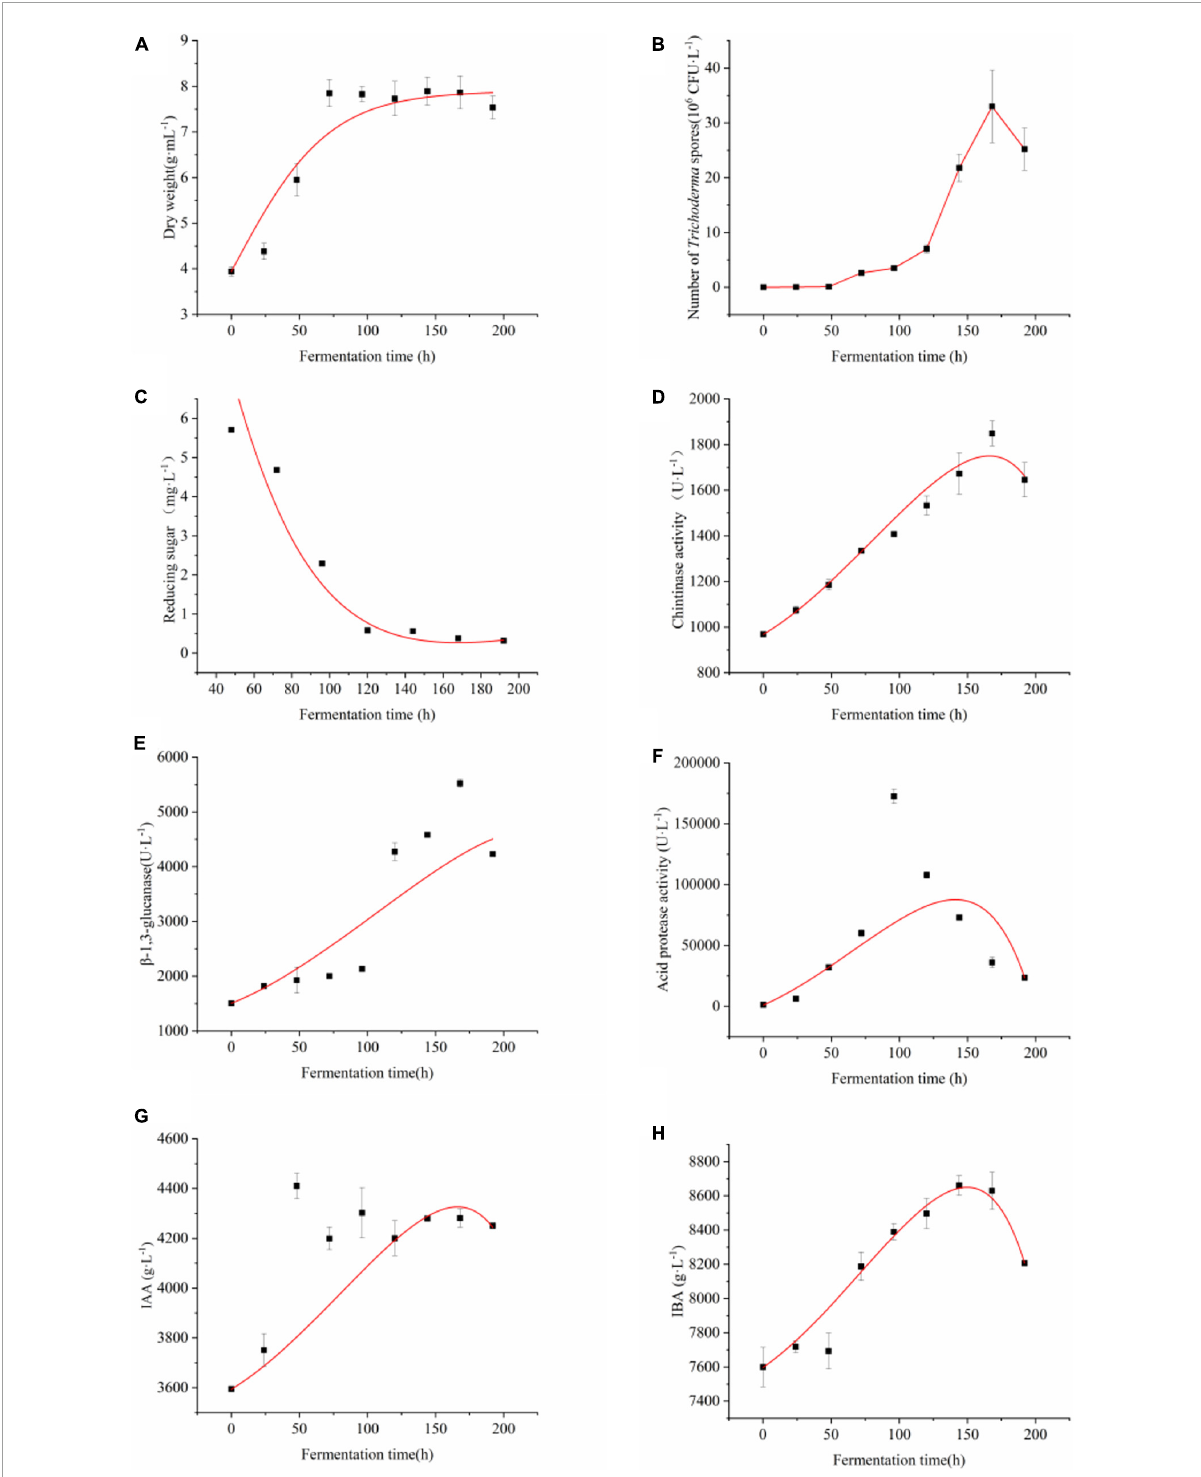
FIGURE2 Time-course of the batch culture of four Trichoderma . Changes of (A) dry weight of Trichoderma (B) number of viable conidial spores of Trichoderma, (C) reducing sugar content, (D) chitinase production β -1,3-glucanase production, (E) β -1,3-glucanase production, (F) acid protease production, (G) IAA production, and (H) IBA production during the co-fermentation process of four Trichoderma . The experiments were done in quintuplicate. The error bars were represented in the graph; standard deviation and mean were